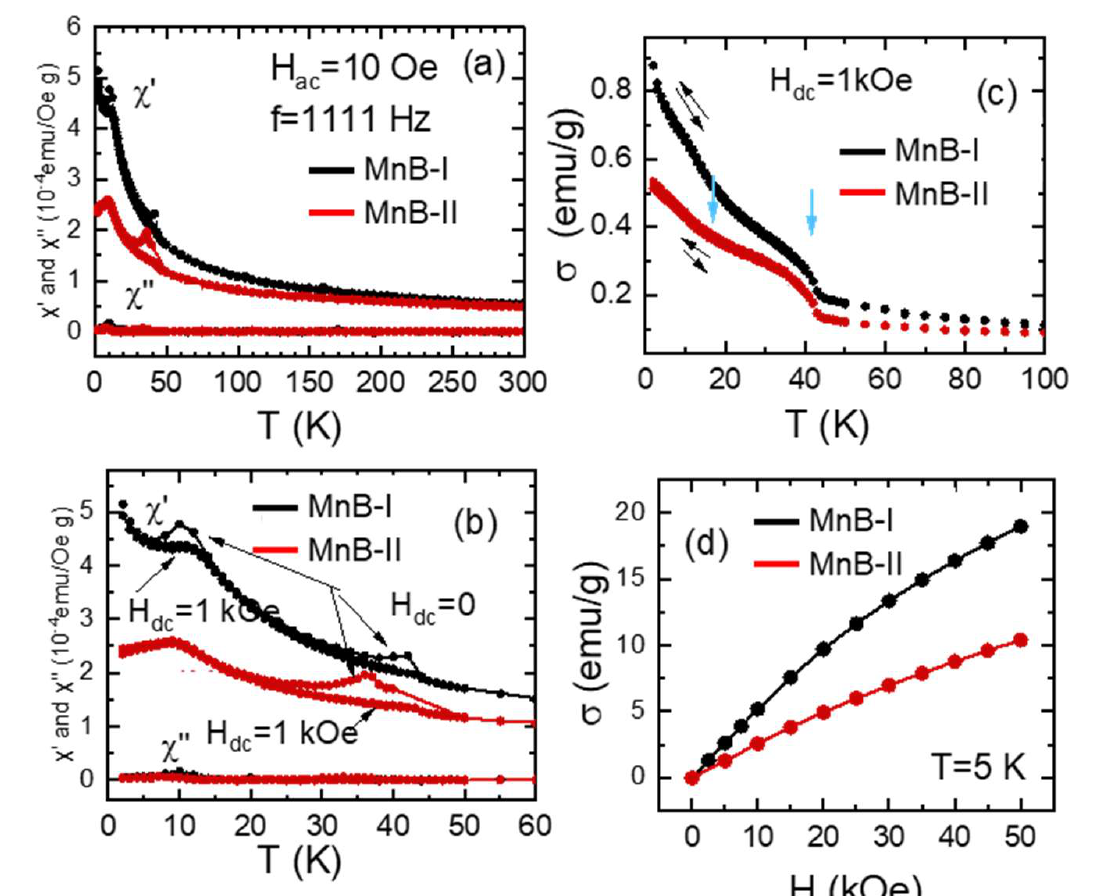
Figure 6. ( a ) Real χ′(T) and imaginary χ″(T) magnetic ac-susceptibility, as a function of temperature, of the samples MnB−I and MnB−II.; ( b ) details of the magnetic ac-susceptibility measurements in the temperature interval T = 0–60 K; ( c ) temperature variation in the dc-magnetic moment per g, of MnB−I and MnB−II samples, measured under 1kOe external magnetic field following the ZFC and FC protocols; ( d ) isothermal at T = 5K variation in the magnetic moment/g for MnB−I and MnB−II samples.